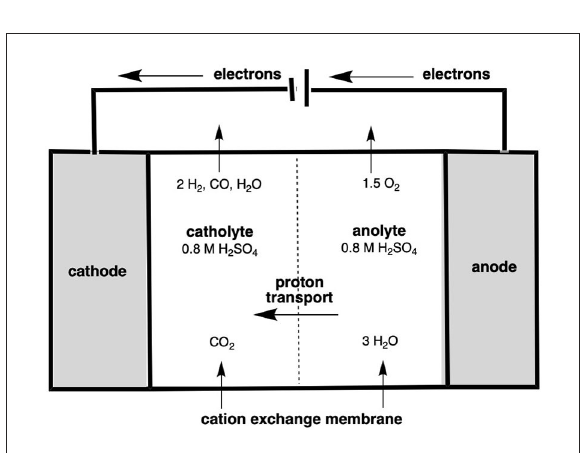
FIGURE8 Electrochemical cell reactor showing the reduction of CO 2 to CO (after Berkelaar et al.,